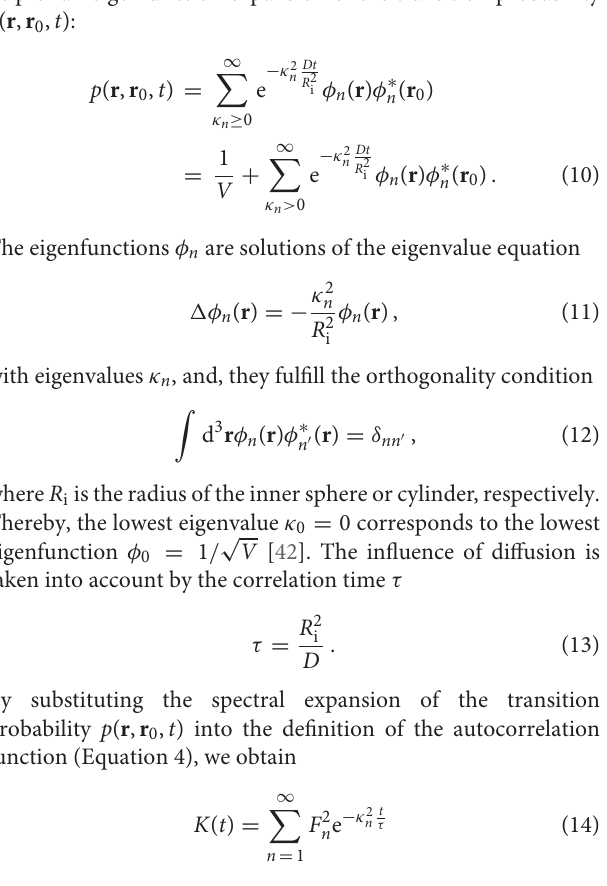
R . In both cases, the rationale of the approach has already been discussed in detail elsewhere [13, 38,